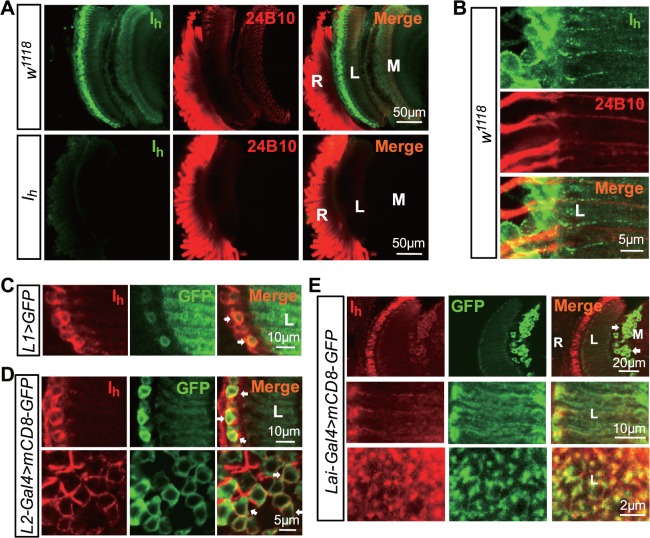
Expression patterns of endogenous Ih channels.(A) Localization of endogenous Ih channels in the adult fly head. Dissected whole heads were double stained with anti-Ih (green) and 24B10 (red, for photoreceptor membrane) antibodies. The images show a longitudinal view of the retina (R), lamina (L), and medulla (M). (B) Distribution of Ih channels in the lamina region. Images show a longitudinal view. (C) Ih channels expressed in L1 neurons. L1 neurons were labeled with mCD8-GFP under the control of the L1-GAL4 driver. Two L1 somata are indicated by arrows. (D). Ih channels were highly expressed in L2 neurons. L2 neurons were labeled with mCD8-GFP under the control of the L2-GAL4 driver. The upper panel shows a longitudinal view of the lamina, and the lower panel shows a cross view of the lamina. L2 somas are indicated by arrows. (E) Ih channels were expressed in ACs. ACs (arrows) are labeled with mCD8-GFP under the control of the Lai-GAL4 driver. The upper panel shows a longitudinal view of the retina (R), lamina (L) and medulla (M), and the middle and lower panels show a longitudinal and cross-sectional view of AC processes.